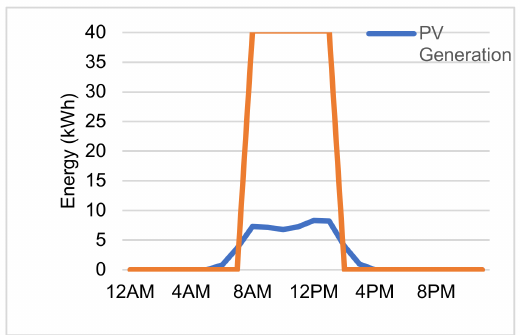
Figure 9. Hourly profile of 2 January (assumed PV system size of 25.9 kWp).